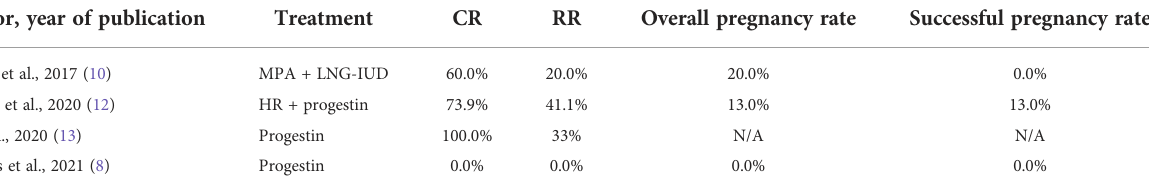
TABLE 2 Outcomes of IA G2